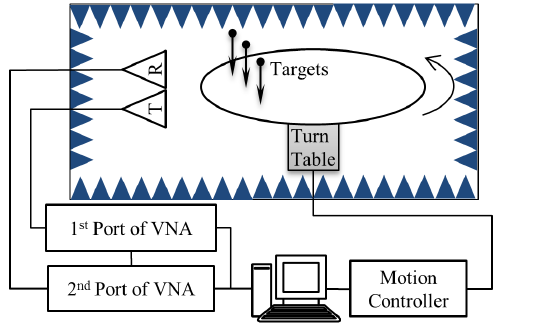
Figure 1. The configuration of the ISAR system using a VNA. The targets are placed at the edge of the turn table, which is far from the center of rotation, in order to emphasize the near-field